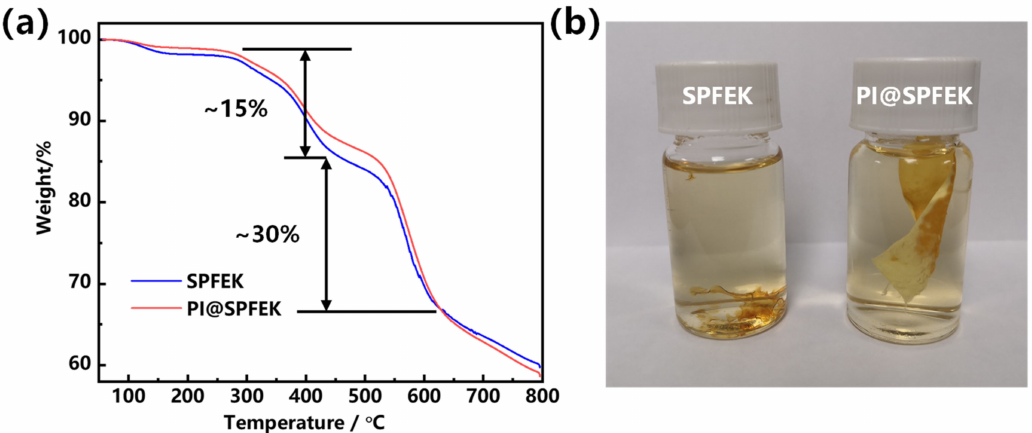
Figure 3. ( a ) Thermogravimetric (TG) analysis curves of SPFEK and PI@SPFEK composite membranes; ( b ) Photograph of SPFEK and PI@SPFEK composite membranes after 1 h of treatment with Fenton’s reagent (3% H 2 O 2 , 4 ppm FeSO 4 ) at 80 ◦